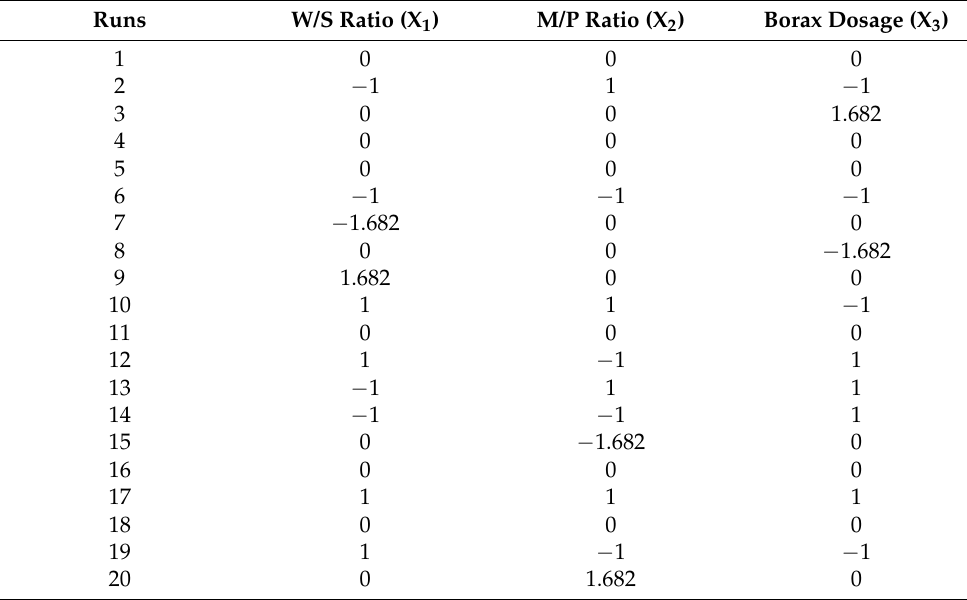
Figure 2. Schematic of the design points with coded values. Table 2. The points for 3 factors CCD design (coded value).